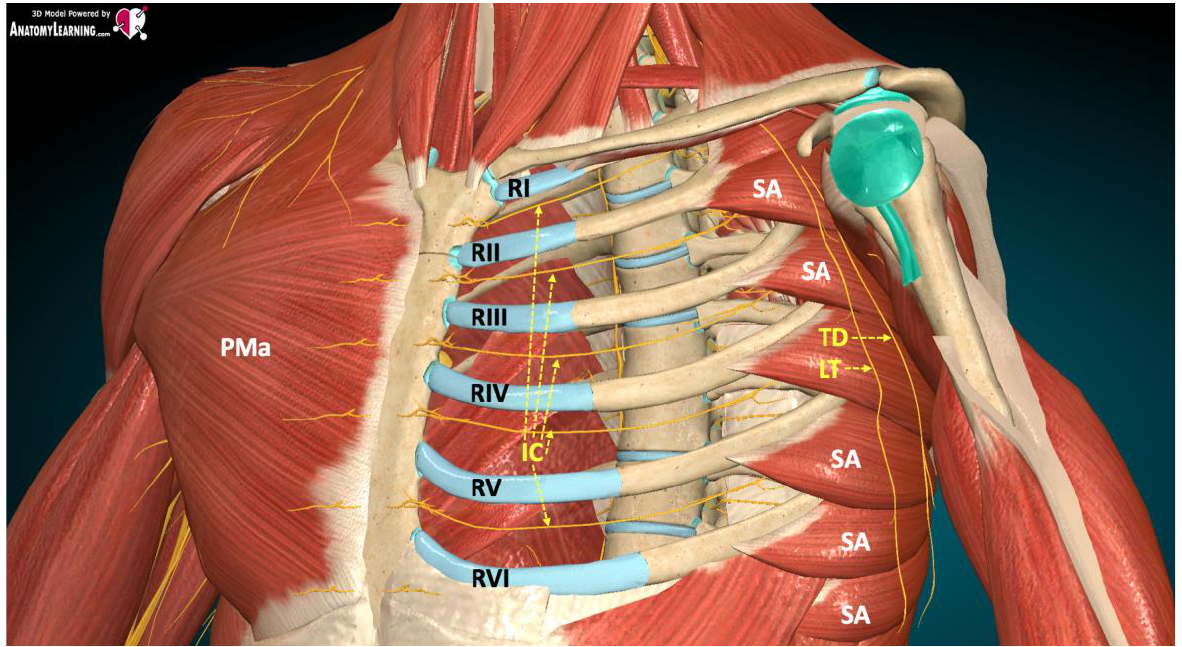
Figure 2. Neuroanatomy of the anterior and lateral thoracic wall [5]. Legend: RI, first rib; RII, second rib; RIII, third rib; RIV, fourth rib; RV, fifth rib; RVI, sixth rib; PMa, pectoralis major muscle; SA, serratus anterior muscle; IC, intercostal nerves; TD, thoracodorsal nerve; LT, long thoracic nerve.